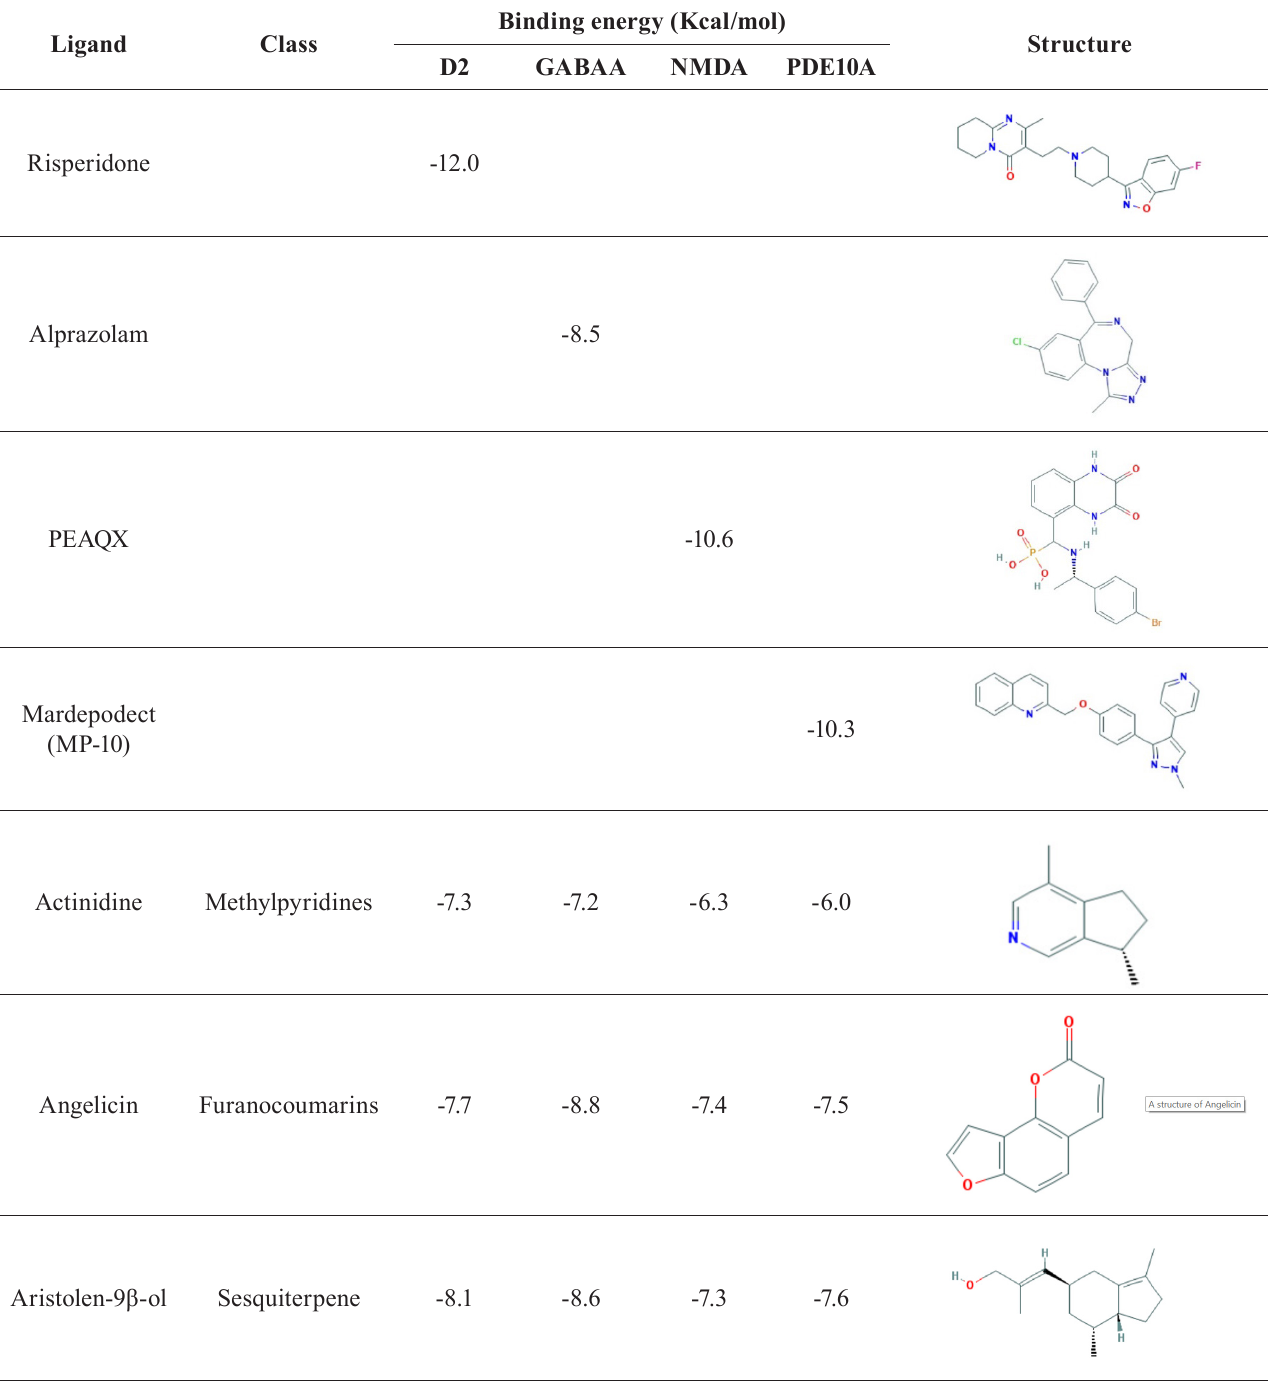
TABLE III - Binding energy of the standards and the active constituents of NJ towards macromolecular drug